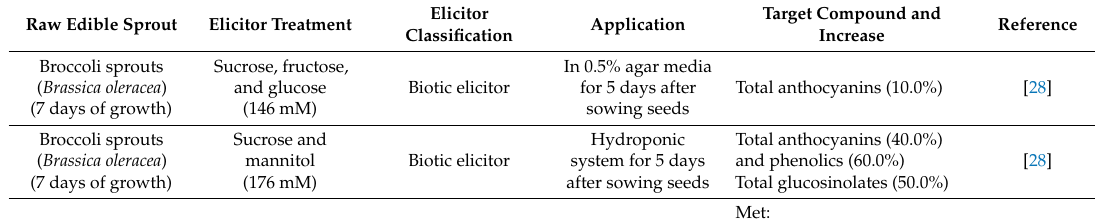
Table 2. Compounds of interest in edible sprouts through different elicitors (update from original table of Baenas et al., 2014